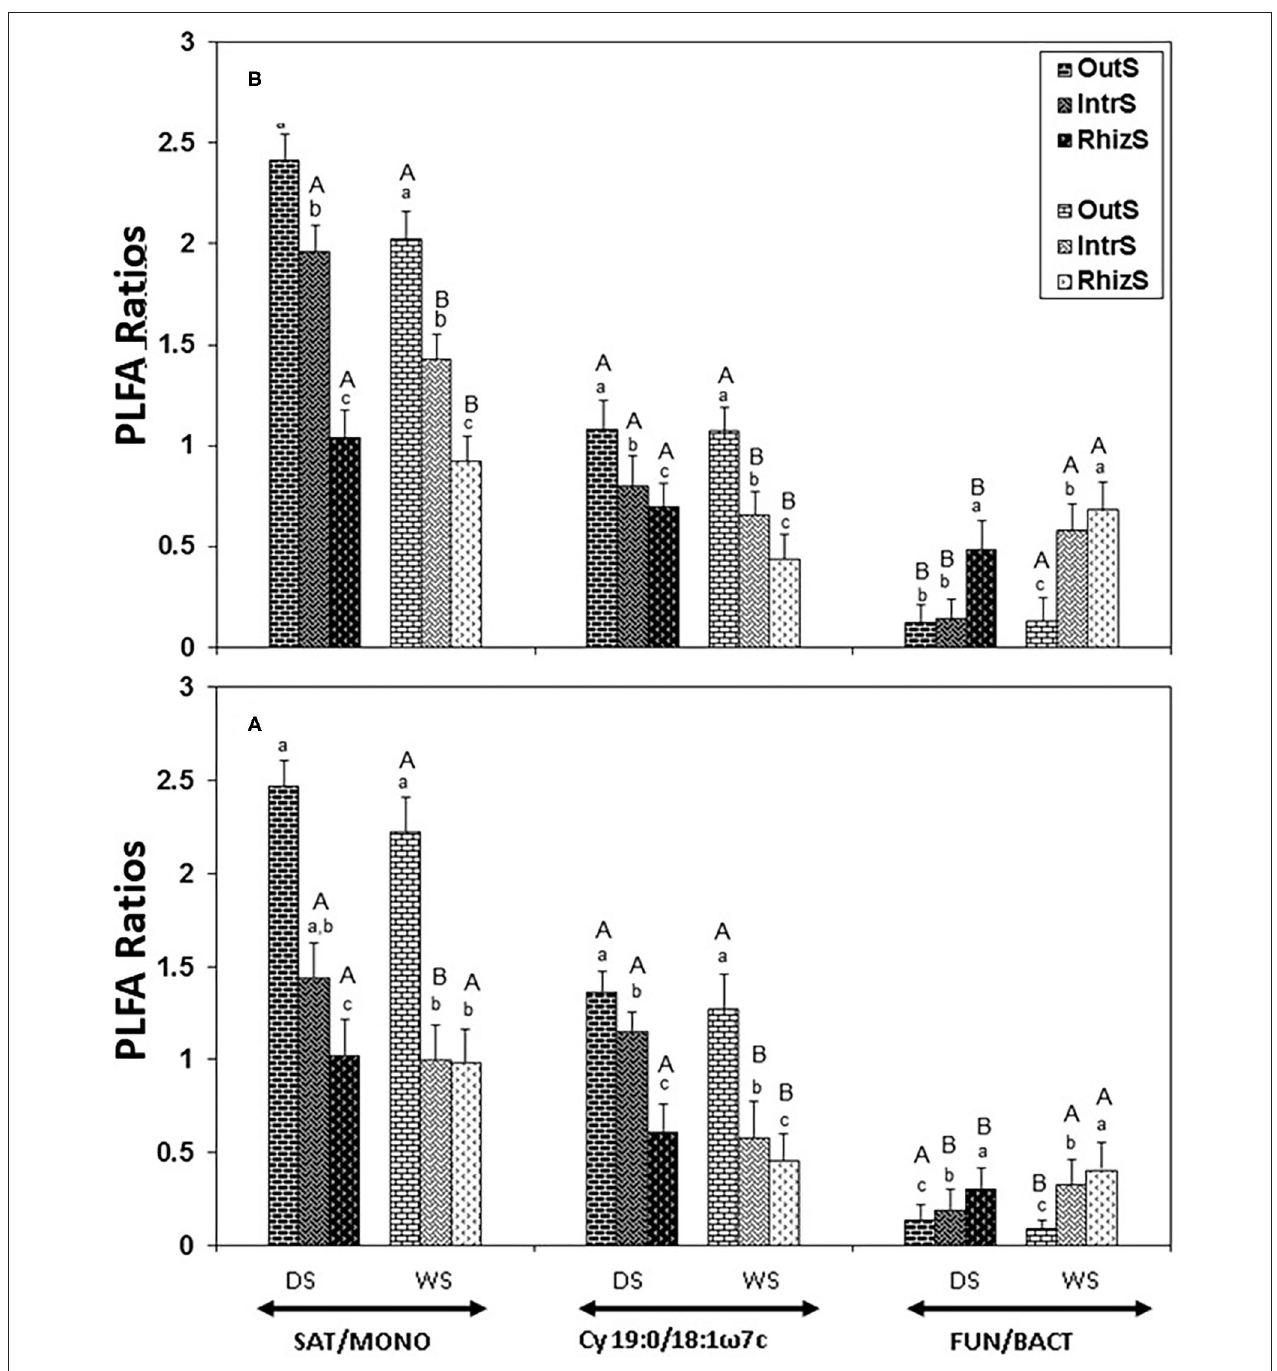
FIGURE 3 | Stress indicators (19:0cy/18:1 ω 7c or SAT/MONO ratios) and FUN/BACT PLFA ratio extracted from soil associated with (A) G. senegalensis , and (B) P. reticulatum . Soil samples (RhizS, shrub rhizosphere soil; IntrS, inter-root soil; and OutS, outside the influence of shrub soil) are from the dry season (DS) and wet season (WS). Bars are standard deviations. The lower case letters represent mean separation between sampling locations and upper case letters represent mean separation between seasons for the same soil location.